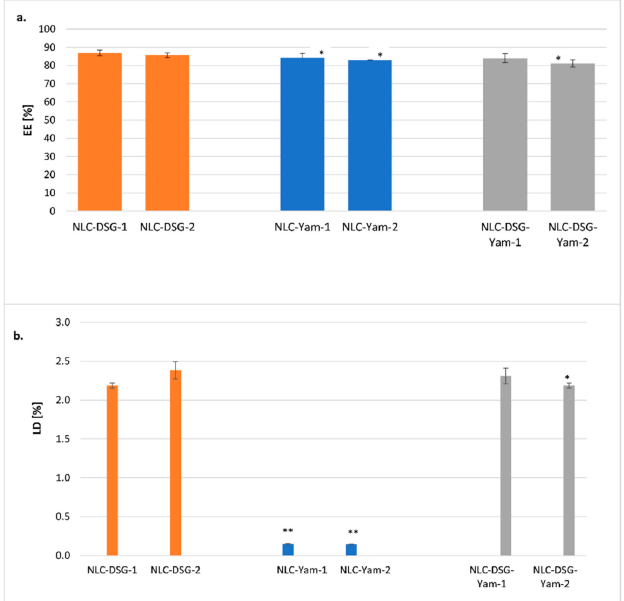
Figure 5. Encapsulation efficiency ( a ) and loading capacity ( b ) of DSG and Yam. * p < 0.05; ** p < 0.005; NS p > 0.05 (NS). Data are expressed as mean ± SD, n = 3 NLC-DSG1/2 vs. other